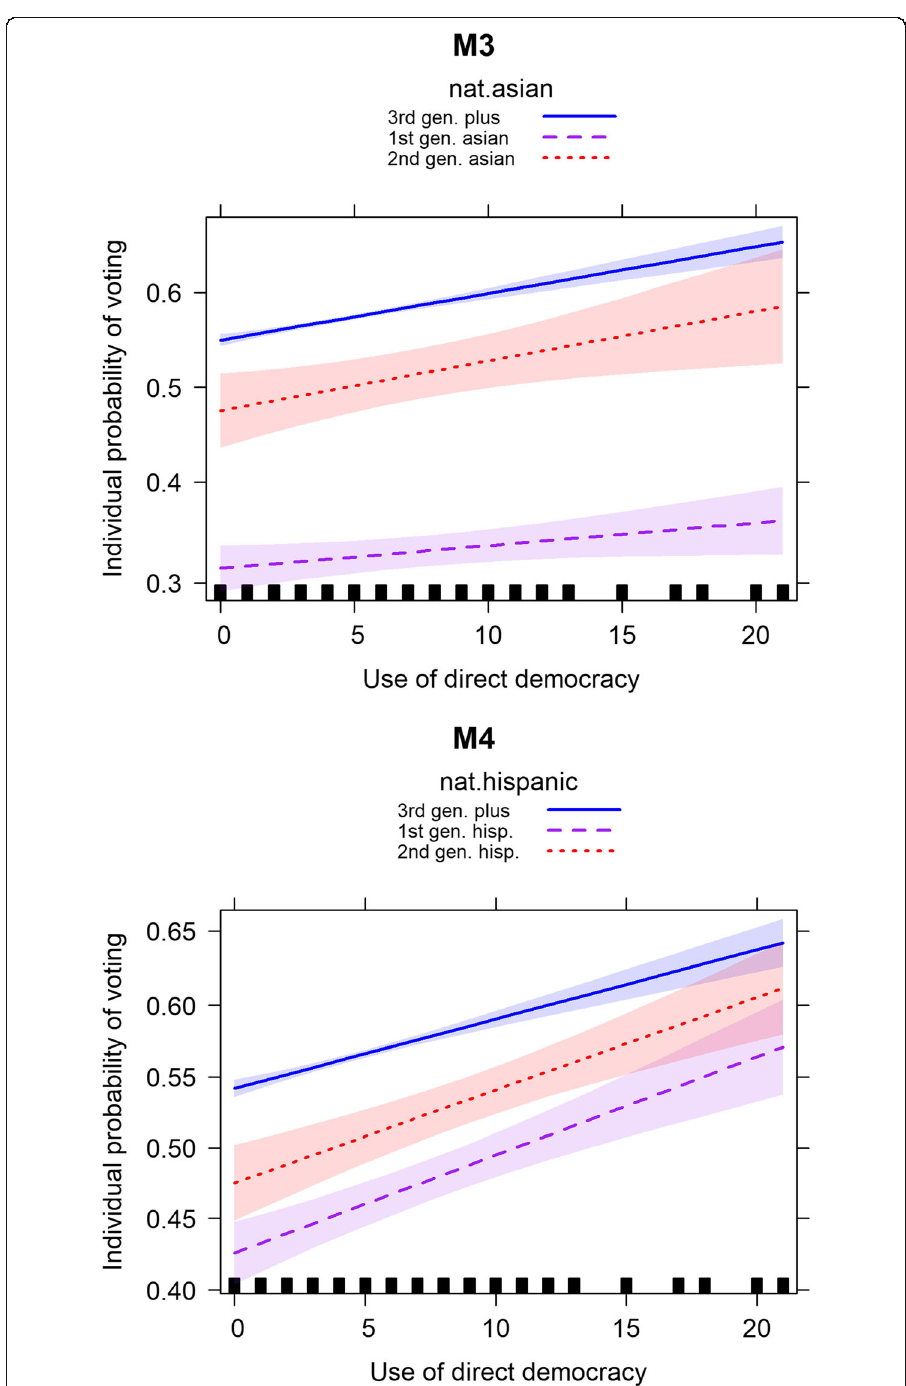
Fig. 1 Predicted individual voting probabilities for different ethnic and nativity groups and use of direct democracy. Note: Predicted voting probabilities (lines) and 95% confidence intervals (bands) for interactions between ethnic and nativity groups and direct democracy based on Models 3 – 4 in Table OA2 in the online